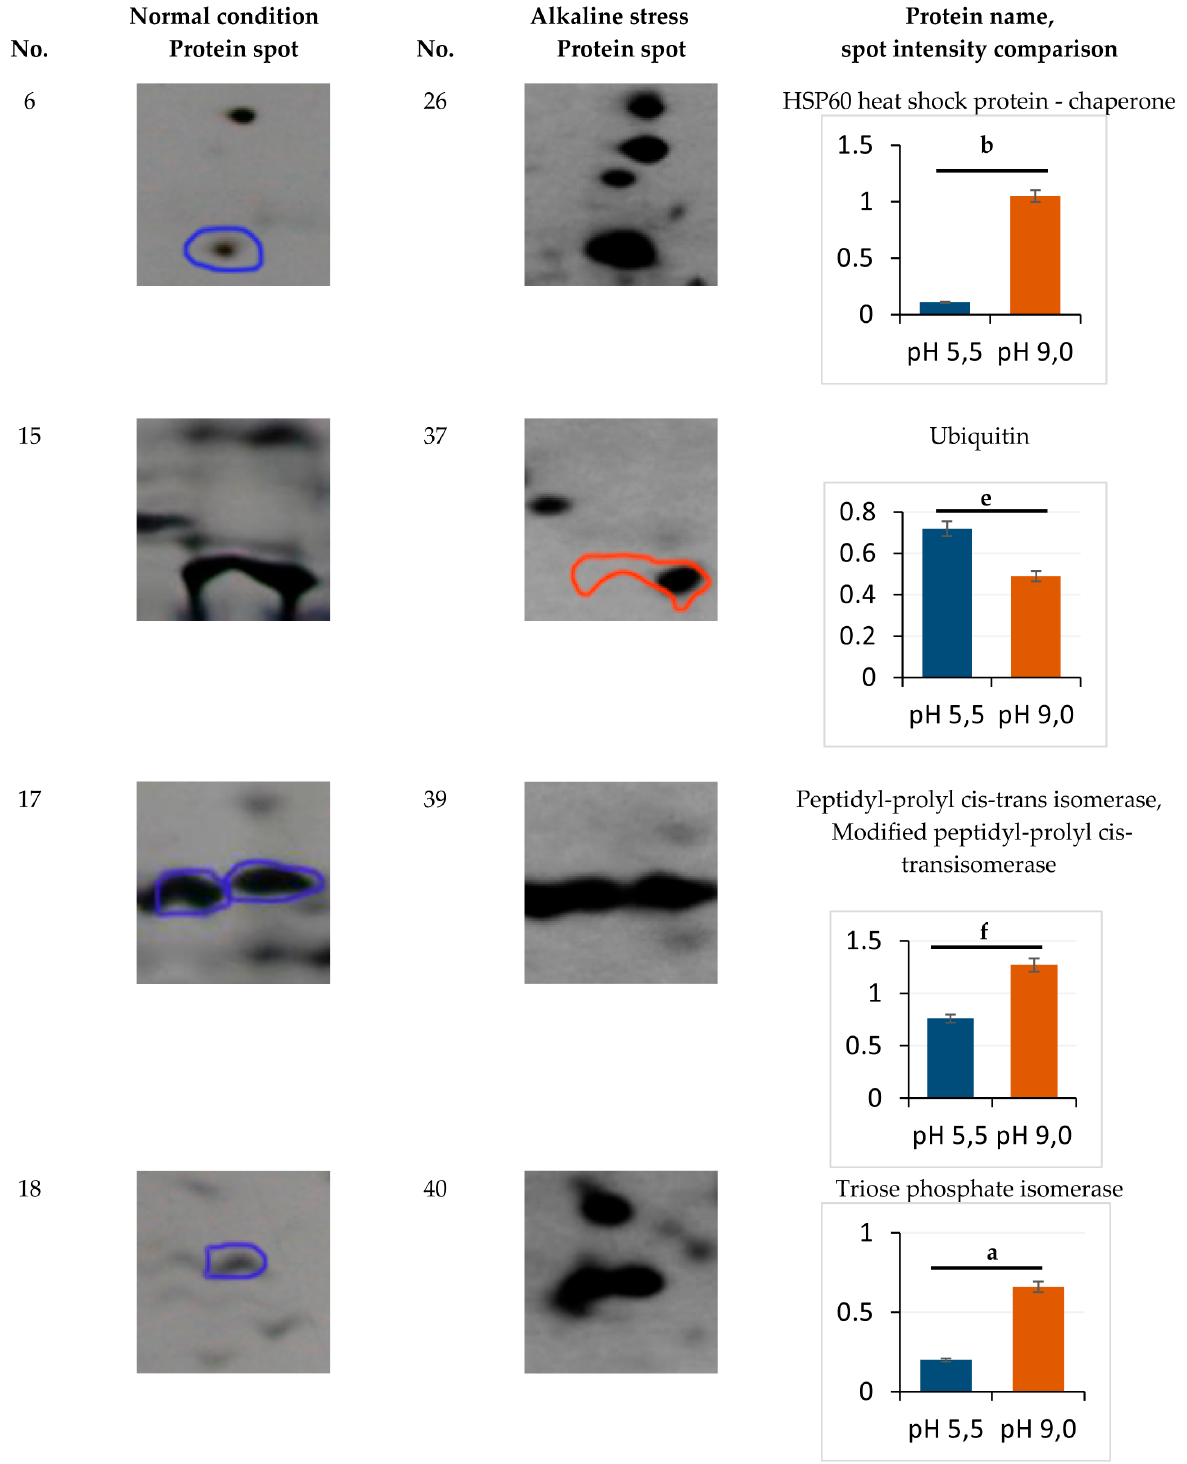
Figure 3. Enlarged sectors of the 2-DE gels including the identified proteins, which were differentially expressed under normal ( left ) and alkaline stress ( right ) conditions. The rightmost column shows the normalized amount of each protein spot. a— p < 0.04; b— p < 0.05; c— p < 0.03; d— p < 0.02; e, f—did not differ significantly. Values are mean ± S.E.M from five independent experiments and three analytical replicates. Symbols: overexpressed proteins under normal (blue circle) and alkaline stress (red circle) condition. The structural protein of YALI0B20306p (zone 5, cell wall mannoprotein) is one of typical proteins for the normal conditions (Table 1). The yeast cell wall is known as